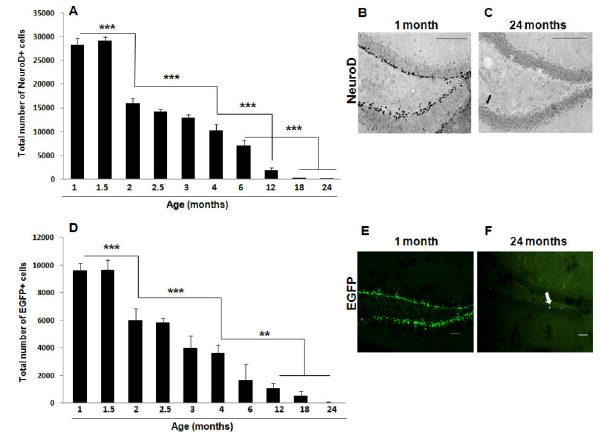
Figure 3. Neuronal differentiation is significantly decreased by age in the mouse hippocampal DG. POMC- EGFP-expressing mice were sacrificed at 1, 1.5, 2, 2.5, 3, 4, 6, 12, 18, 24 months of age by transcardial perfusion and their brains were processed for immunohistochemistry for the immature neuronal marker NeuroD (A-C) and visualized for the expression of EGFP (D-F). Age induced a significant decline in the expression of both NeuroD (A-C) and EGFP (D-F). An abrupt reduction in neuronal differentiation was detected early on (between 1.5 and 3 months of age) with both markers. Data are presented as means ± SEM. (A) *** p < 0.001 between 1 or 1.5 and 2 months, between 2 and 4 months, between 4 and 12 months, and between 6 and 18 or 24 months. (D) ** p < 0.01 between 4 and 12, 18, or 24 months, *** p < 0.001 between 1 or 1.5 and 2 months, and between 2 and 4 months. See text for additional statistical details. Representative sections of the DG processed for NeuroD immunohistochemistry (B, C) and analyzed for EGFP expression (E, F) in 1- (B, E) and 24- (C, F) month old POMC-EGFP mice. Arrows indicate a NeuroD- immunopositive cell (C) and an EGFP-expressing cell (F) in the DG of a 24-month old mouse. Scale bars (B, C) = 100 µm; scale bars (E, F) = 50